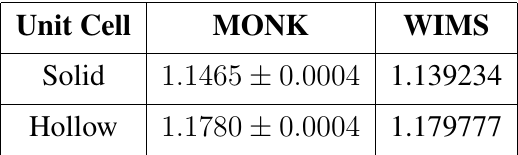
Table I: Infinite multiplication factor for different unit